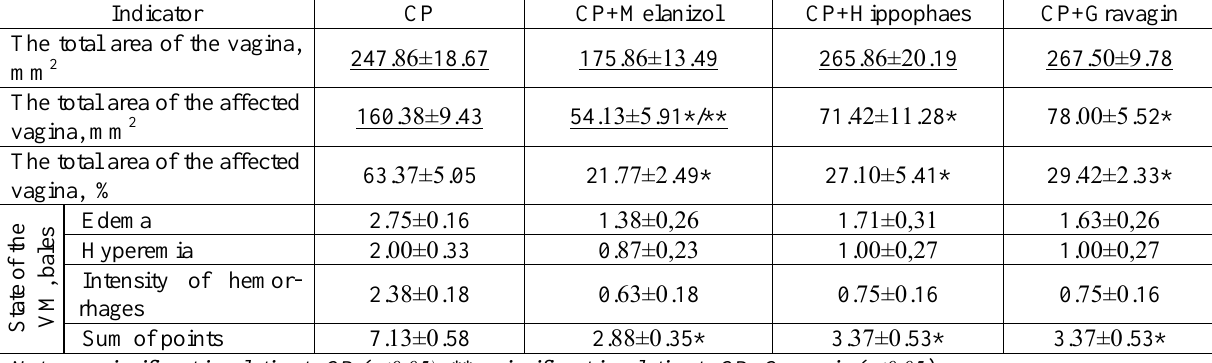
Influence of the research agents on the state of SOP rats on the background of "mechanical" vaginitis on the 11 th day